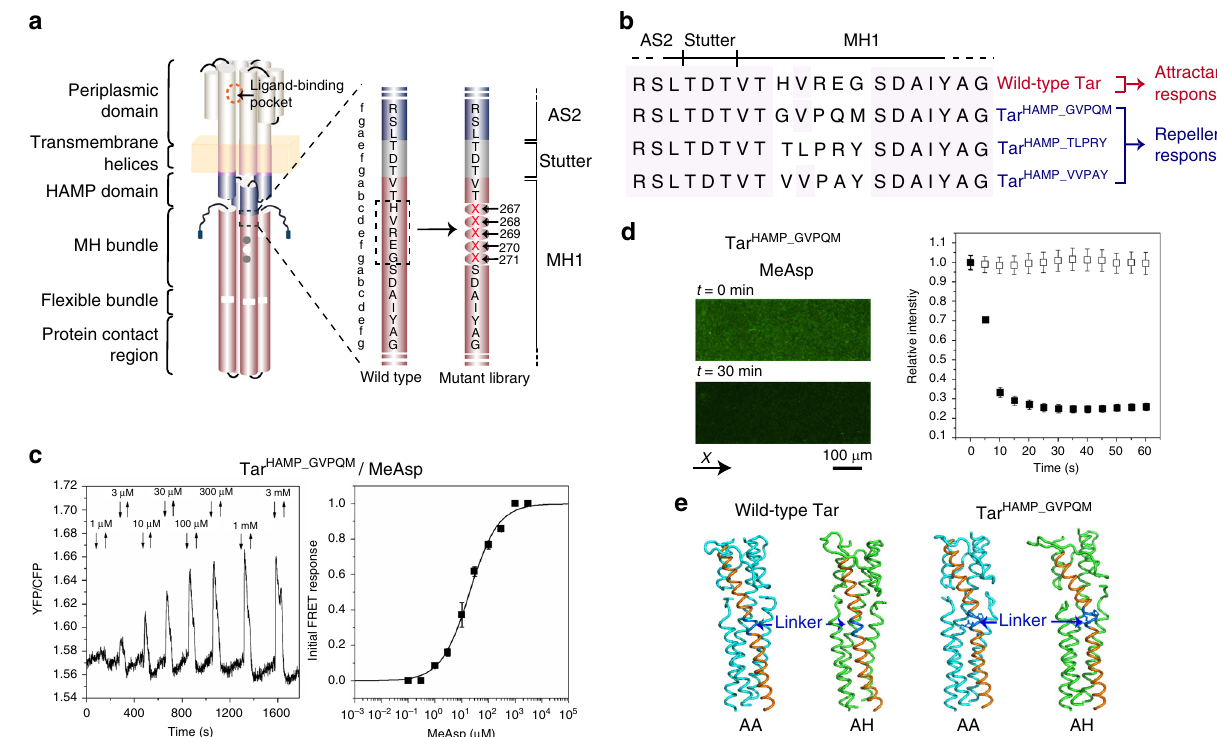
Fig. 3 Repellent responses of Tar with mutations after the HAMP domain. a Schematic representation of the Tar[1 – 266]-XXXXX-[272 – 553] library with a random linker region made after the HAMP domain of Tar. b Sequence alignment for the wild-type and mutant Tar receptors. The receptors that induced attractant or repellent responses to MeAsp are indicated. c FRET measurements and dose response of E. coli CheR + CheB + strain VS181, expressing Tar HAMP_GVPQM as a sole receptor, as well as the FRET pair, to a stepwise addition and subsequent removal of the indicated concentrations of